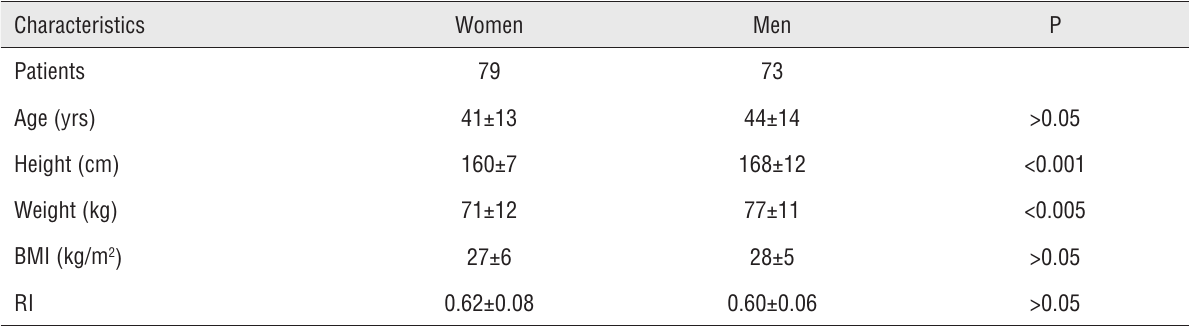
Table 1 - Demographic